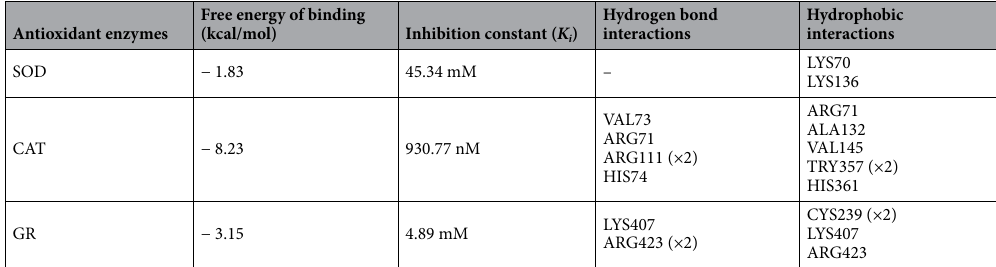
Table 7. Energy involved during molecular interactions of pendimethalin with antioxidant enzymes.